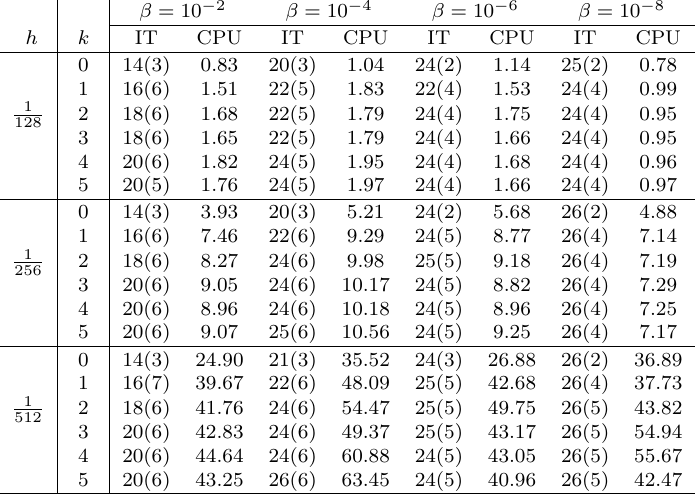
Table 2. Problem 1: Performance of the block-diagonally preconditioned MINRES, equa- tions (33) and (34) in [21] β = 10 −